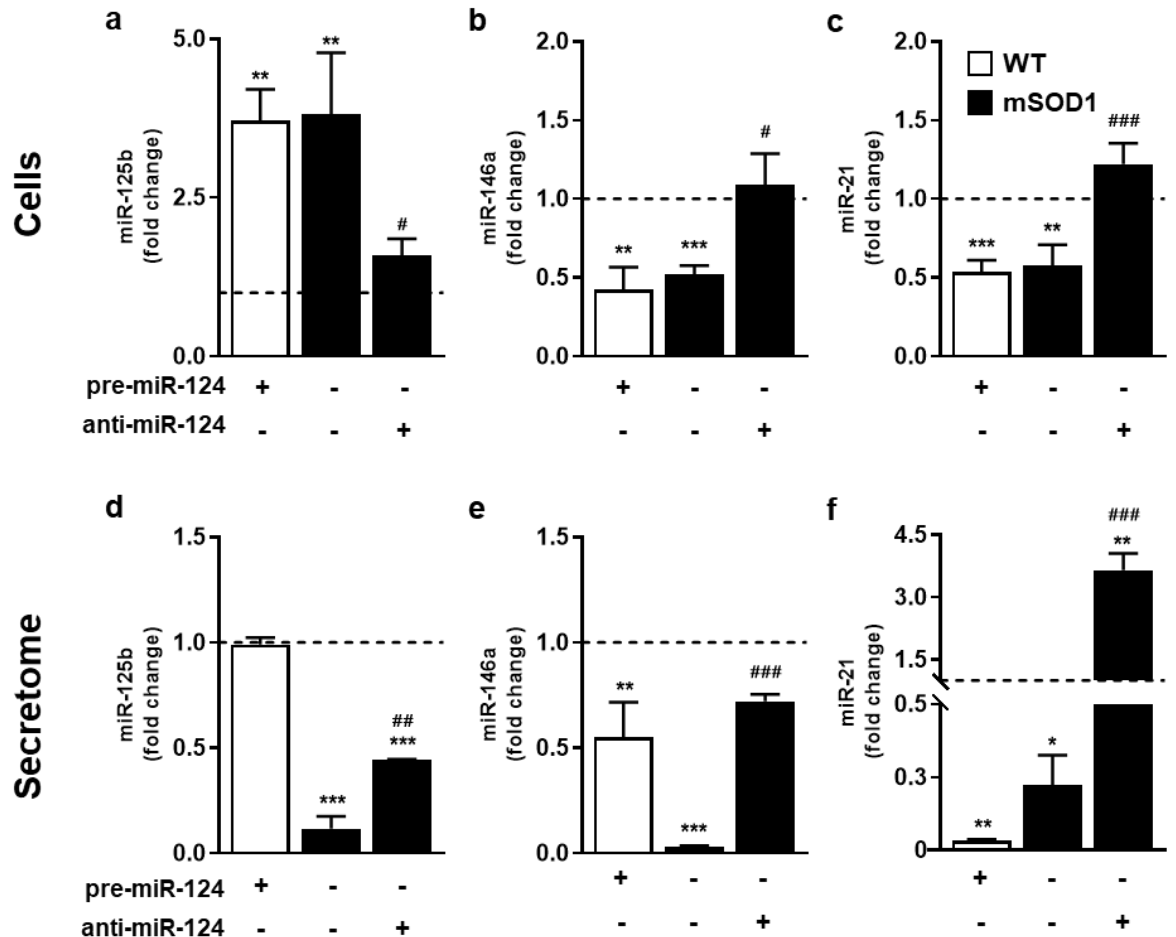
Figure 2. Targeting of miR-124 toward normal values in MNs enriched in miR-124 abrogates miR-125b overexpression and causes miR-146a/miR-21 downregulation in both cells and secretome, thus inhibiting a pathological inflamma-miRNA profile in mSOD1 MNs. After 2 days of differentiation, NSC-34 WT and mSOD1 MNs were transfected with pre-miR-124 or anti-miR-124, respectively, for 12 h and maintained for additional 48 h. Cells and derived secretome were collected for miRNA isolation. SNORD110 and RN1UA1 were used as reference genes. ( a , d ) miRNA-125b, ( b , e ) miRNA-146a, and ( c , f ) miR-21 levels in cells and their derived secretome were evaluated by reverse transcriptase quantitative real-time PCR (RT-qPCR). Results are mean ± SEM from at least 6 independent experiments and expressed as fold change vs. WT MNs (dashed line). *** p < 0.001, ** p < 0.01, and * p < 0.05 vs. WT MNs; ### p < 0.001, ## p < 0.01, and # p < 0.05 vs. mSOD1 MNs; one-way ANOVA followed by multiple comparisons Bonferroni post-hoc correction. MNs, motor neurons; mSOD1, MNs overexpressing G93A mutation in superoxide dismutase 1; WT, wild